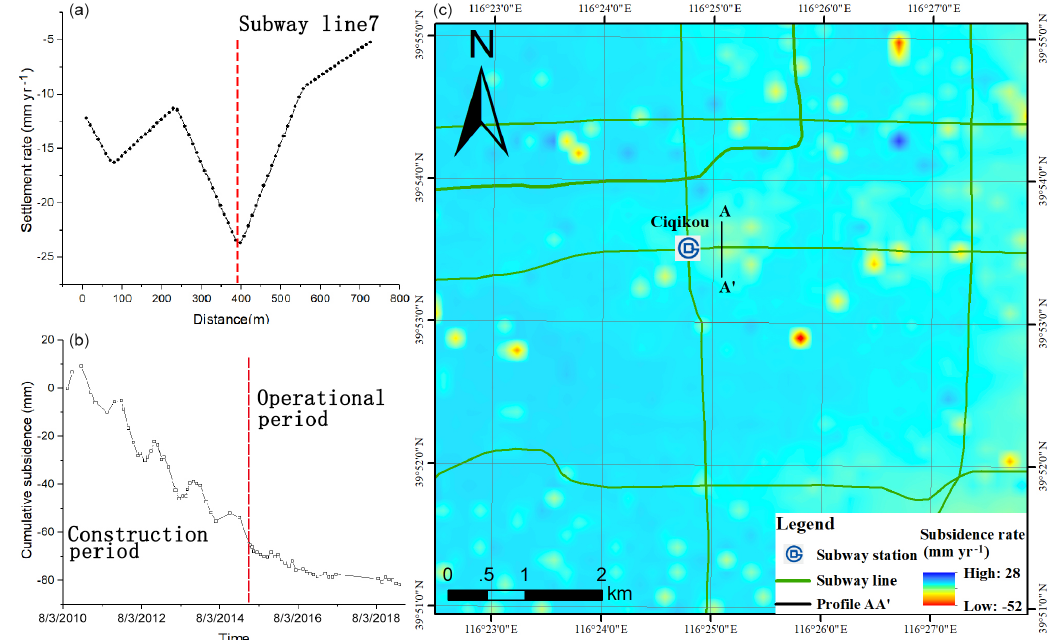
Figure 4. Average subsidence rete perpendicular to Beijing subway line 7 during 13 April 2010 to 10 December 2018. Subsidence rate profile AA’ at Ciqikou station (a) . Time series of coherent target above Ciqikou station (b)